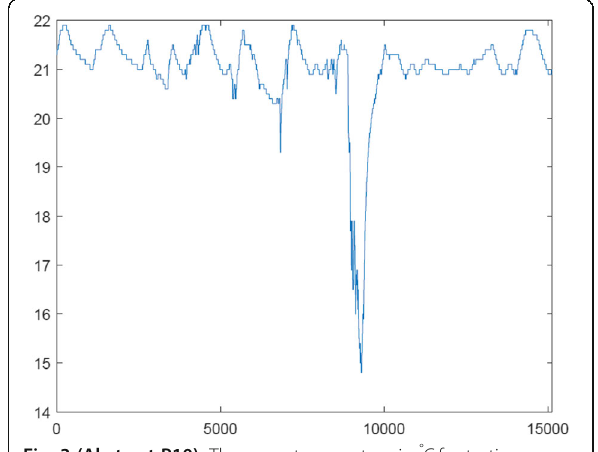
Fig. 3 (Abstract P10). The room temperature in ° C.for testing data